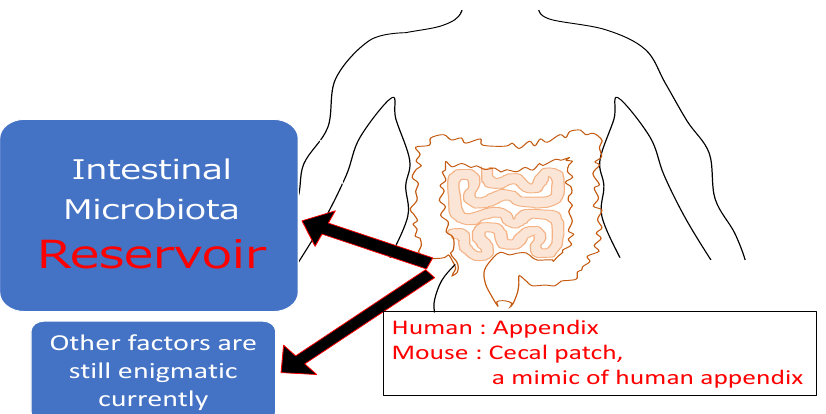
Figure 2. The roles of the appendix (cecal patch): The appendix is a narrow, worm-shaped sac, which has well-organized lymphoid tissue that directly attach it and is a reservoir of commensal bacteria. Currently, other factors are still highly enigmatic about this organ.